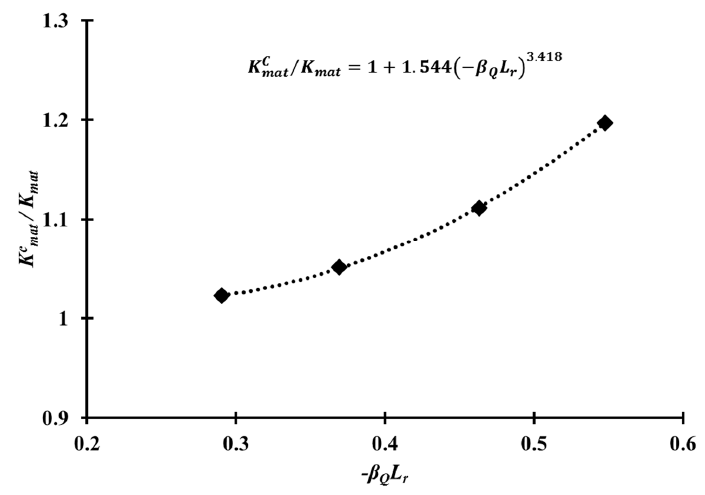
Figure 9. J-Q locus of the Al 5083-O weldment at cryogenic temperature.